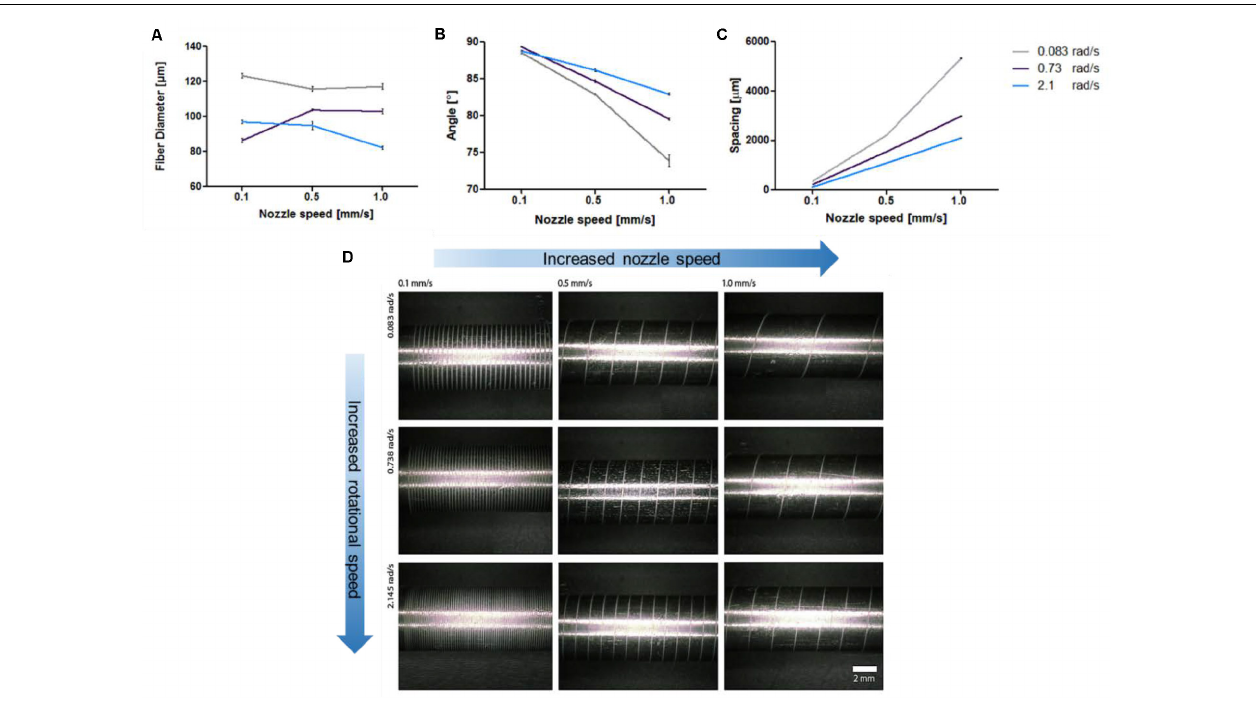
FIGURE 4 | Optimization of 3D printed reinforced designs. (A) Decrease of fiber diameter with increased speed. (B) Decreased fiber angle with respect to the mandrel with increased speed. (C) Increased spacing between the 3D printed strands with increased speed. (D) Micrographs of 3D printed reinforced architectures on a stainless steel mandrel at different nozzle movement speed and mandrel rotational speed. The optimization was performed using PCL polymer.